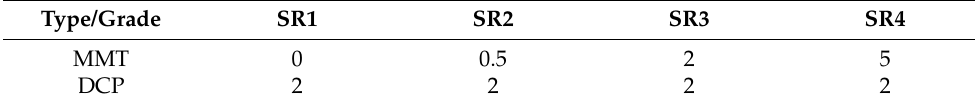
Table 2. Nanocomposite filler formulations (in weight percent, remaining is SR).